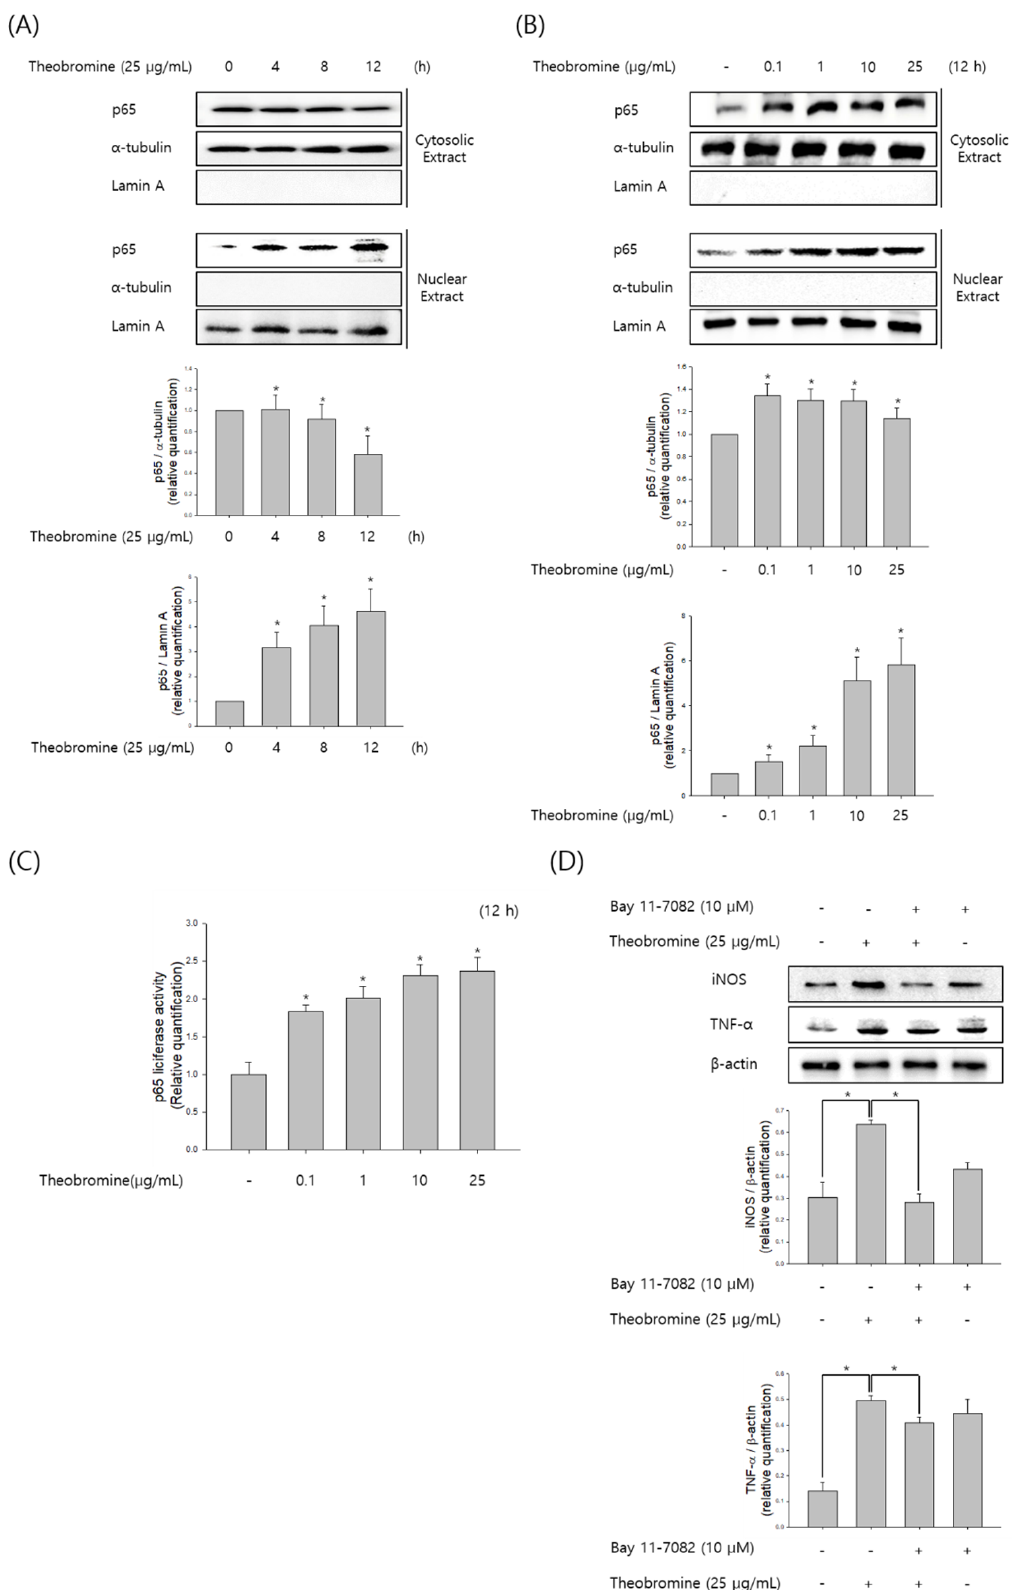
Figure 4. Effect of theobromine on the activation and translocation of NF- κ B in RAW 264.7 macro- phages. Macrophages were stimulated with theobromine for 4 h. ( A , B ) The level of p65 was deter- mined at the indicated times or concentrations by Western blot assay to analyze the translocation of NF- κ B. ( C ) Macrophages were transfected with a pGL3-p65-Luc reporter plasmid and β -galacto-